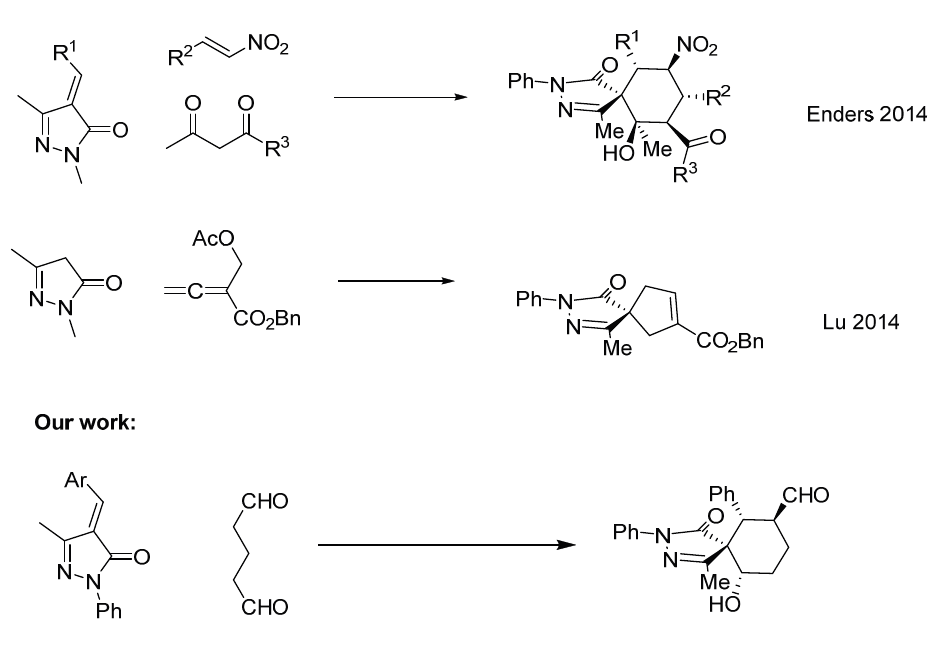
Figure 1. Previous reactions and our